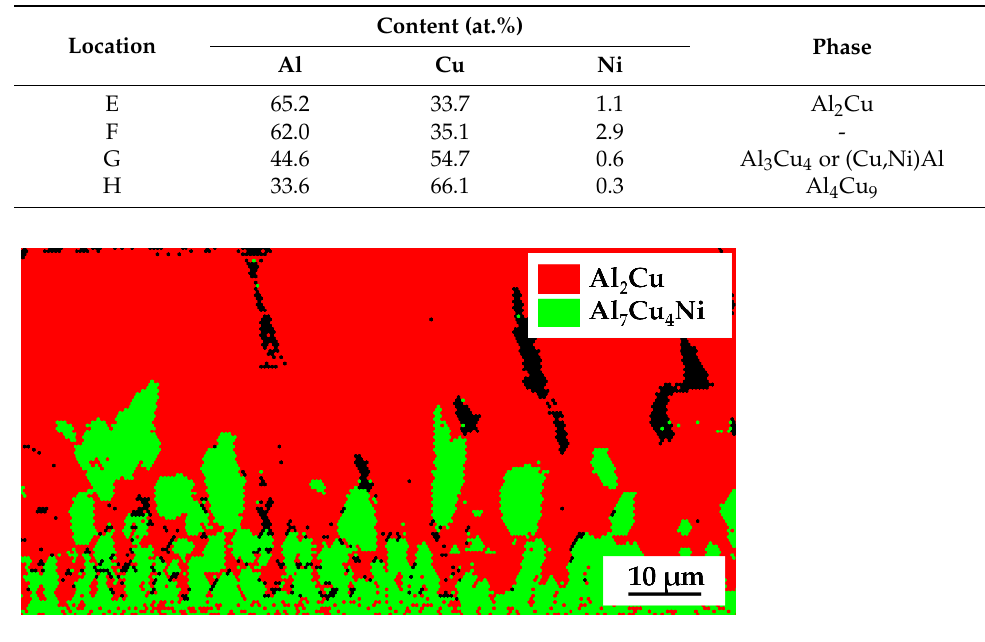
Figure 6. Electron backscatter diffraction (EBSD) phase map at the Al 2 Cu layer with Ni-containing particles formed at the joint by the addition of 2.3 at.% Ni.